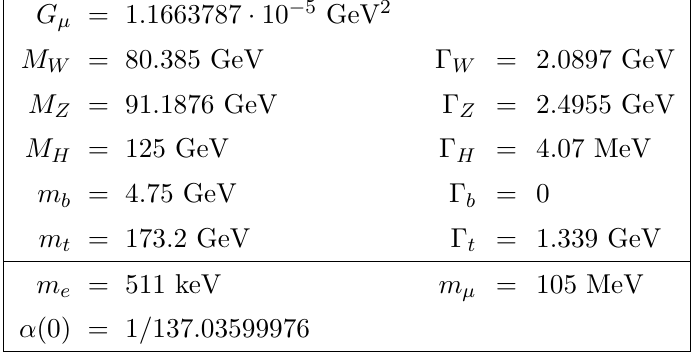
Table 1 . Numerical values of all input parameters. The gauge boson masses are taken from [59], while their widths are obtained from state-of the art calculations. The Higgs mass and width are taken from [60]. The top quark mass is taken from [59] while its width has been calculated at NLO QCD. The electron and muon masses as well as the electromagnetic coupling in the Thomson limit, (cid:11) (0), are only relevant for calculations involving YFS soft-photon resummation and the Csshower